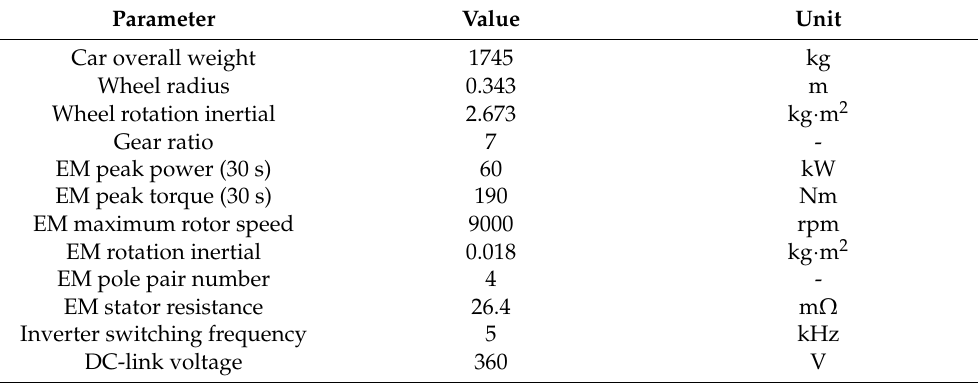
Table 1. Parameters of the reference vehicle and the reference electric